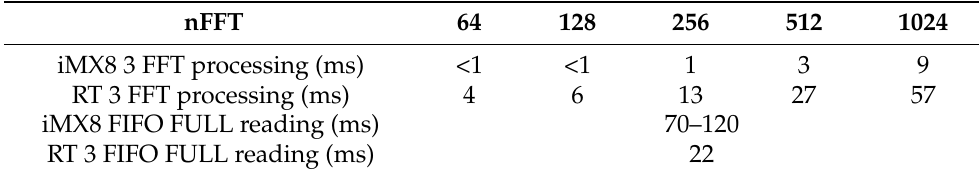
Table 3. iMX8 Vs RT performance comparison.